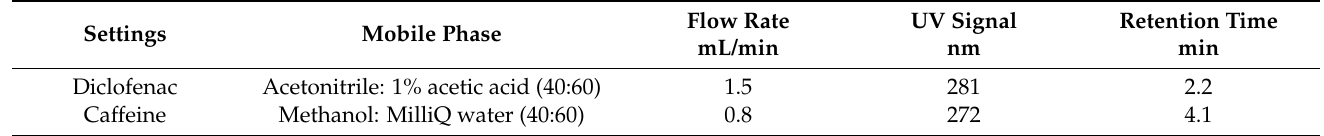
Table 1. Method settings for HPLC